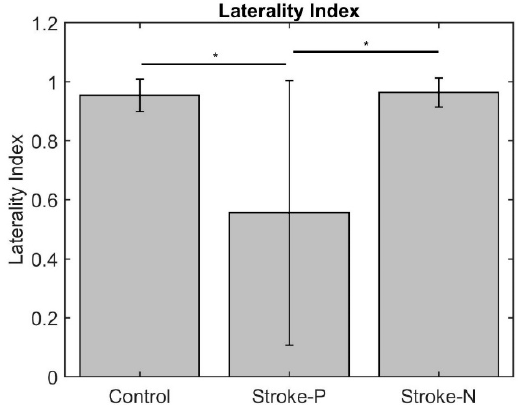
while bilateral source activities were shown in individuals after a stroke (Figures 8–10).